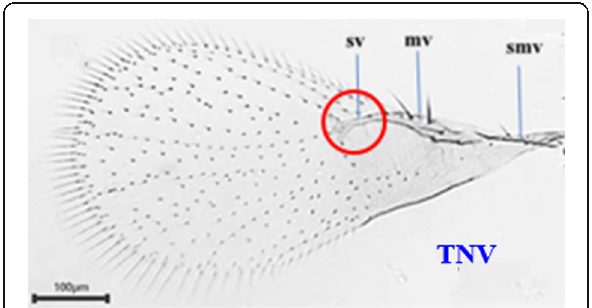
Fig. 12 Light micrograph of TNV forewing: ( sv stigmal vein, mv marginal vein, and smv submarginal